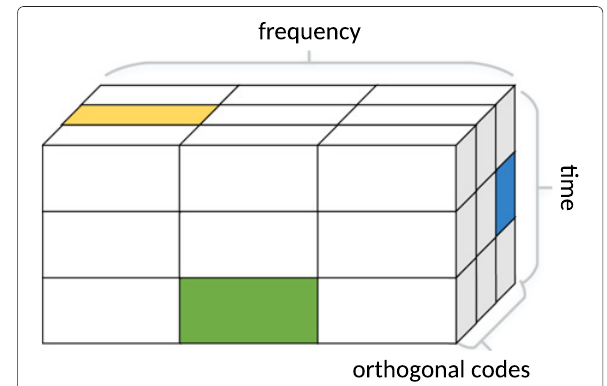
Fig. 6 Matrix with three resource dimensions and full isolation between communication channels